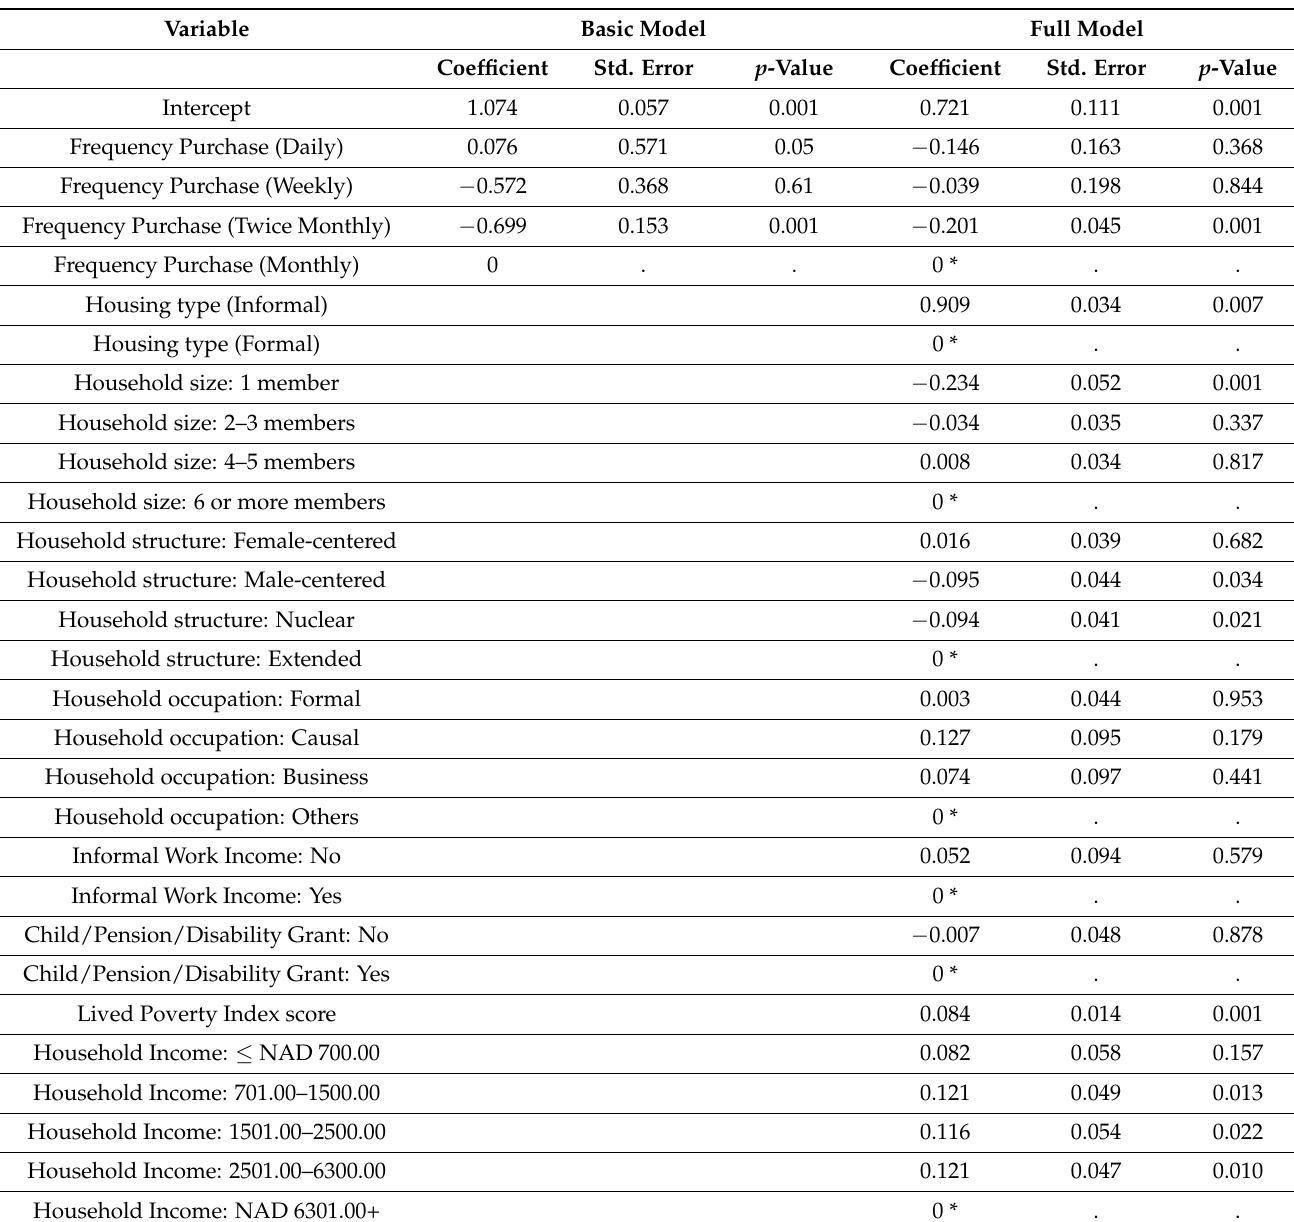
Table 2. Results of predictors of food insecurity in Windhoek, Namibia using the univariate probit